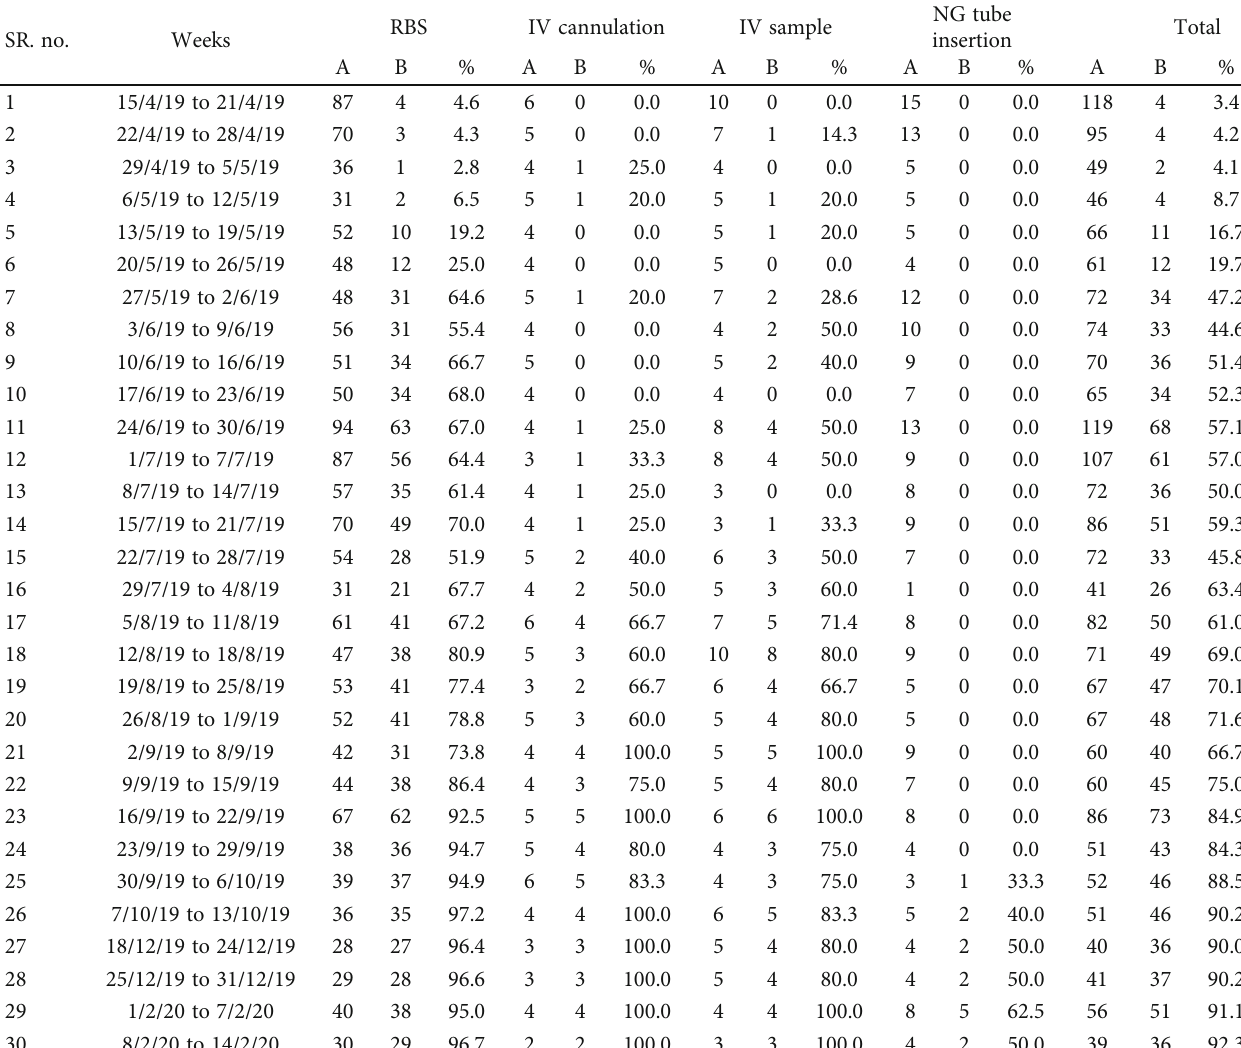
Table 1: Weekly data with subgroup